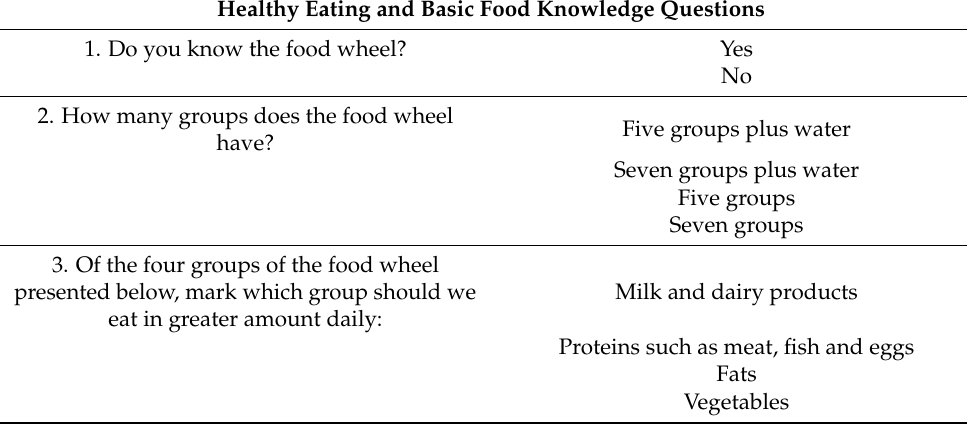
Healthy eating and basic food knowledge and physical activities and leisure habits